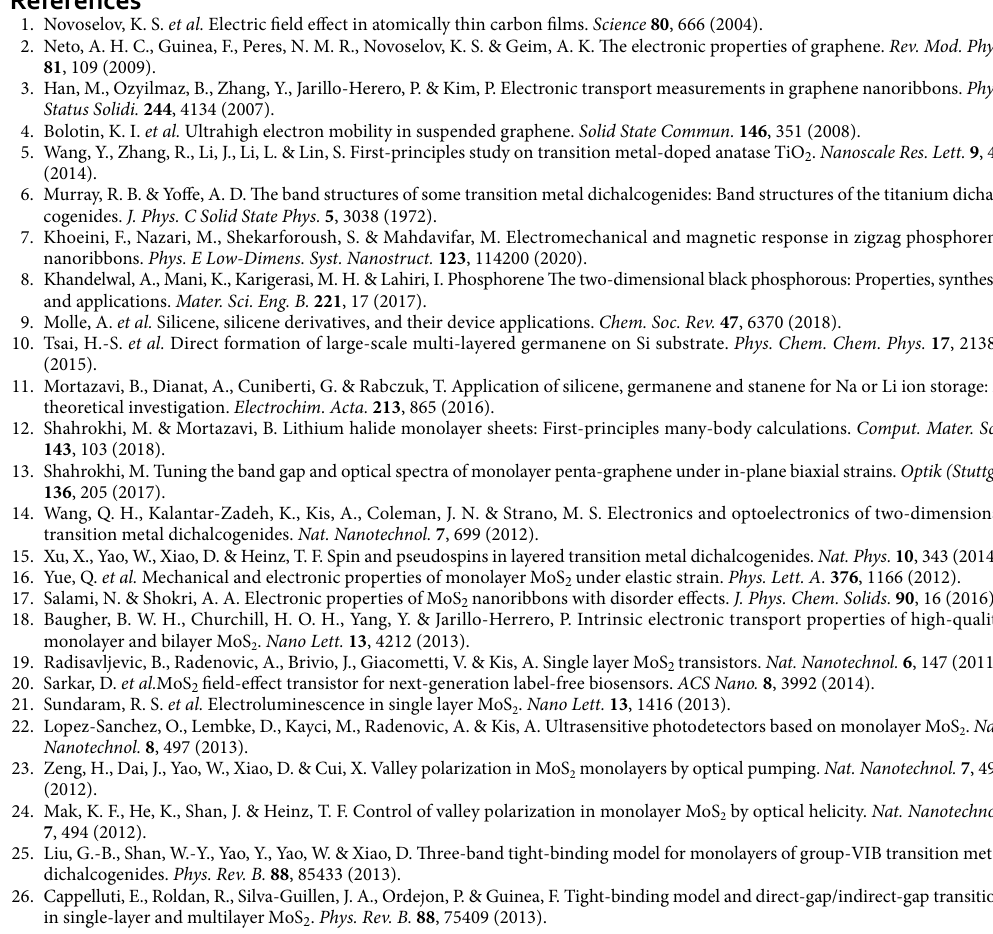
0.0 eV, 0.1 eV, 02 =